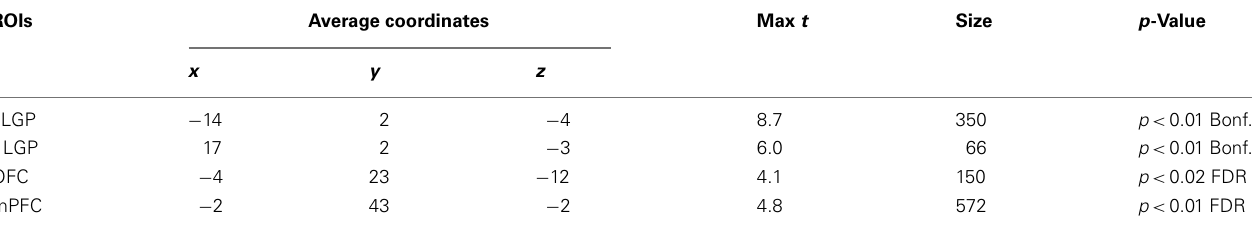
Table 2 |Areas in universal network for counterfactuals. ROIs